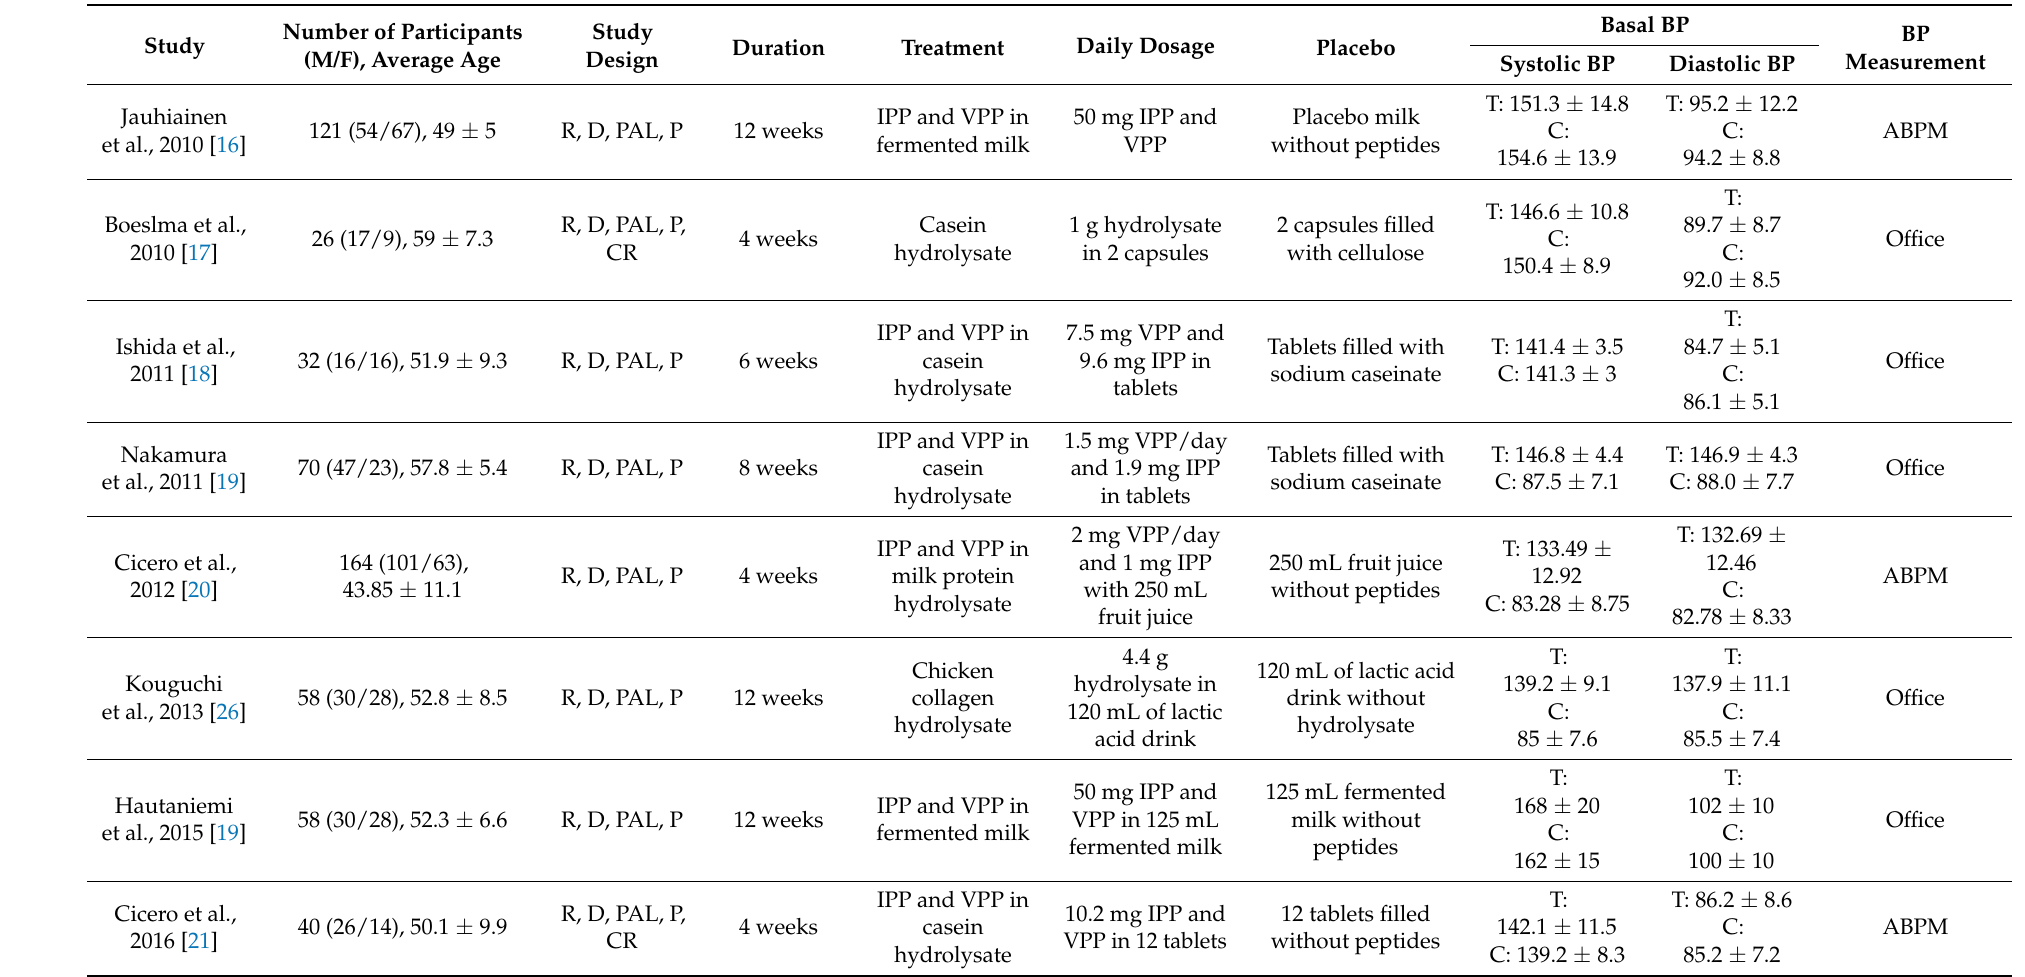
Table 1. Characteristics of the included